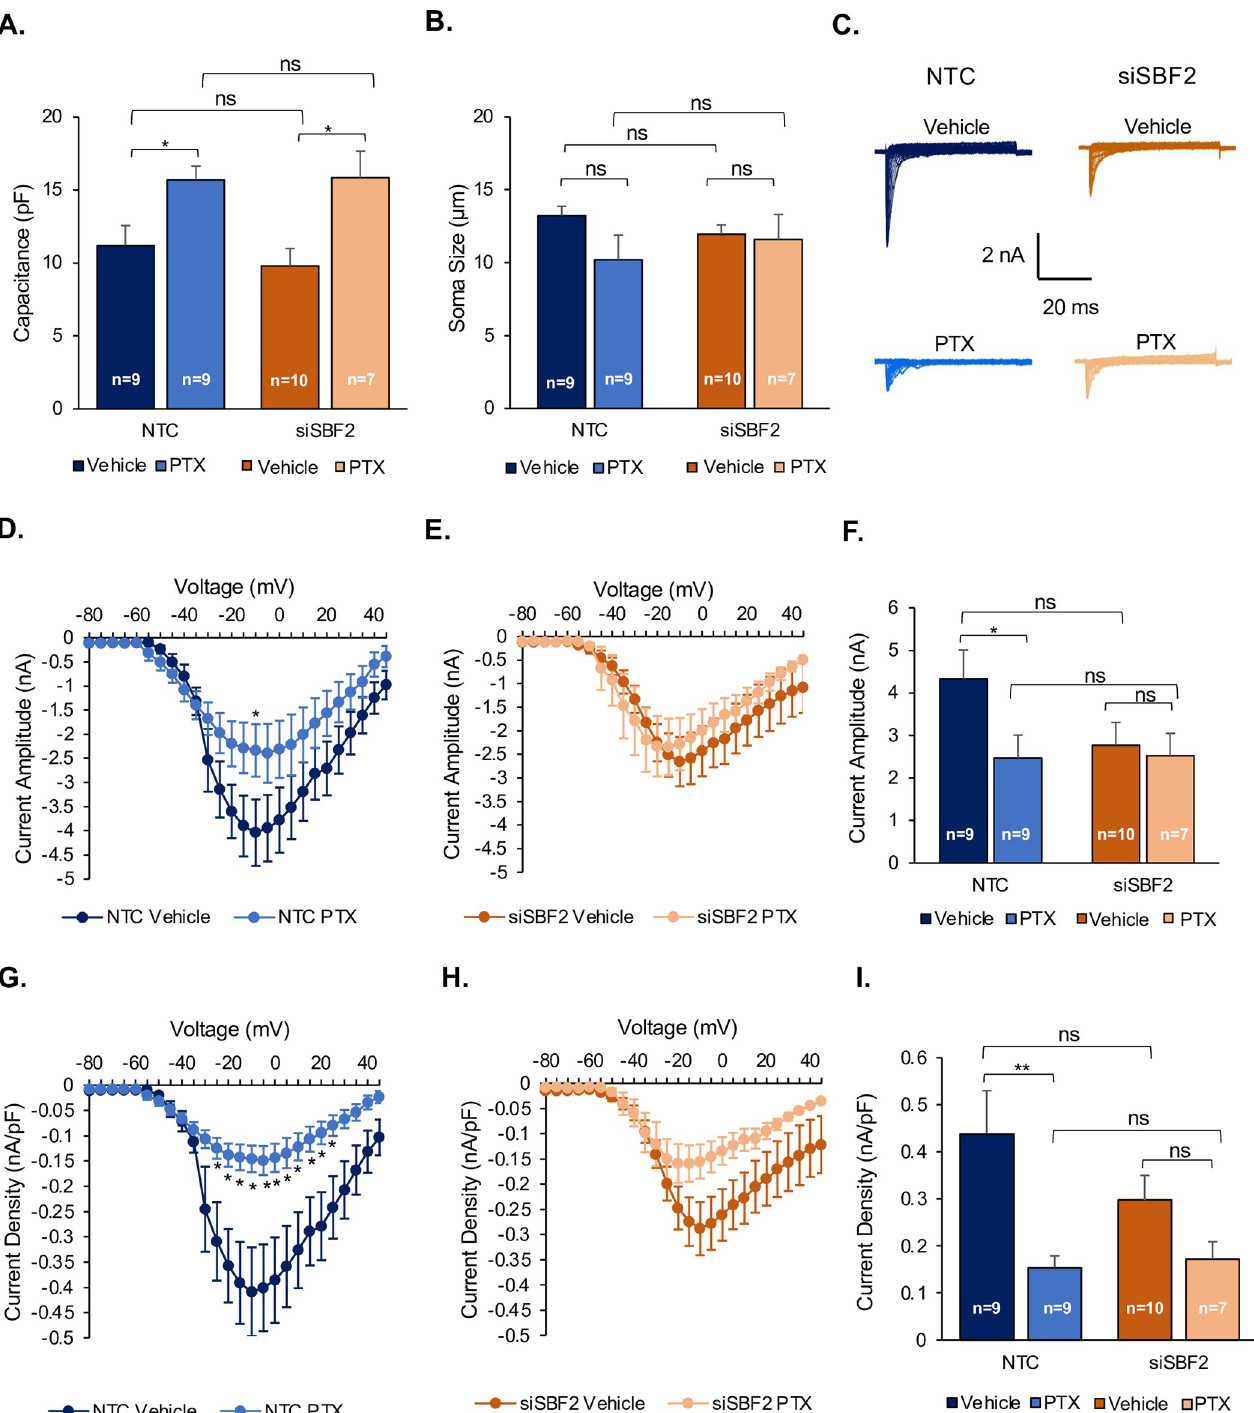
Fig 4. si SBF2 attenuates paclitaxel-induced sodium currents inhibition. A) Quantification of membrane capacitance. B) Quantification of soma size. C) Representative sodium currents in each group. D) and E) Sodium current amplitude comparing treatment in NTC (D) and si SBF2 (E) cells. F) Quantification of sodium peak current amplitude. G) and H) Sodium current density comparing treatment in NTC (G) and si SBF2 (H) cells. I) Quantification of sodium peak current density. Vehicle-treated groups are represented in dark blue (NTC) and dark orange (si SBF2 ); Paclitaxel-treated groups are represented in light blue (NTC) and light orange (si SBF2 ). The number of cells measured for each parameter is represented within each bar. (NTC = non-targeted control, PTX = paclitaxel, ns = non-significant, � = p < 0.05, �� = p < 0.01). Error bars represent SEM.